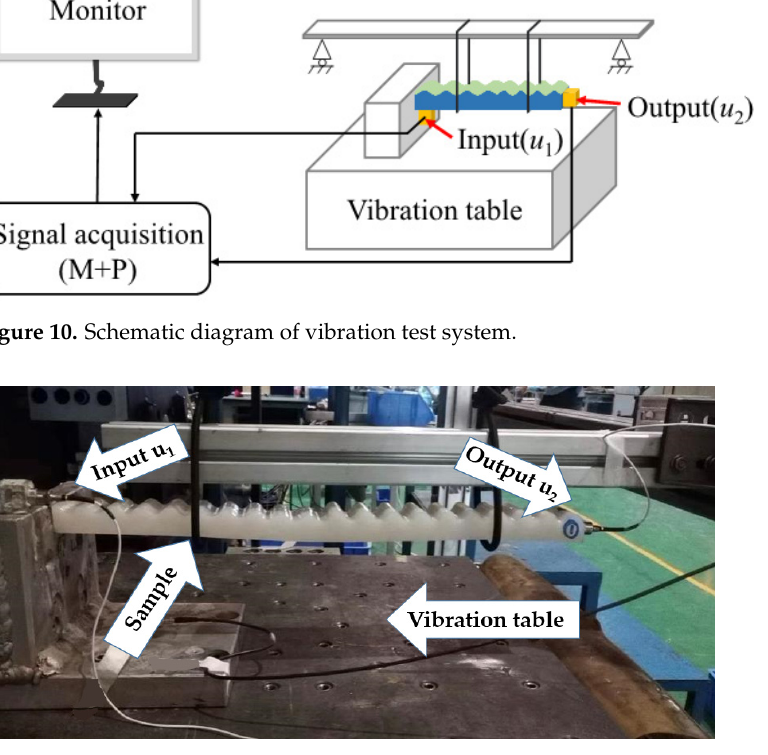
Figure 11. Vibration test setup.